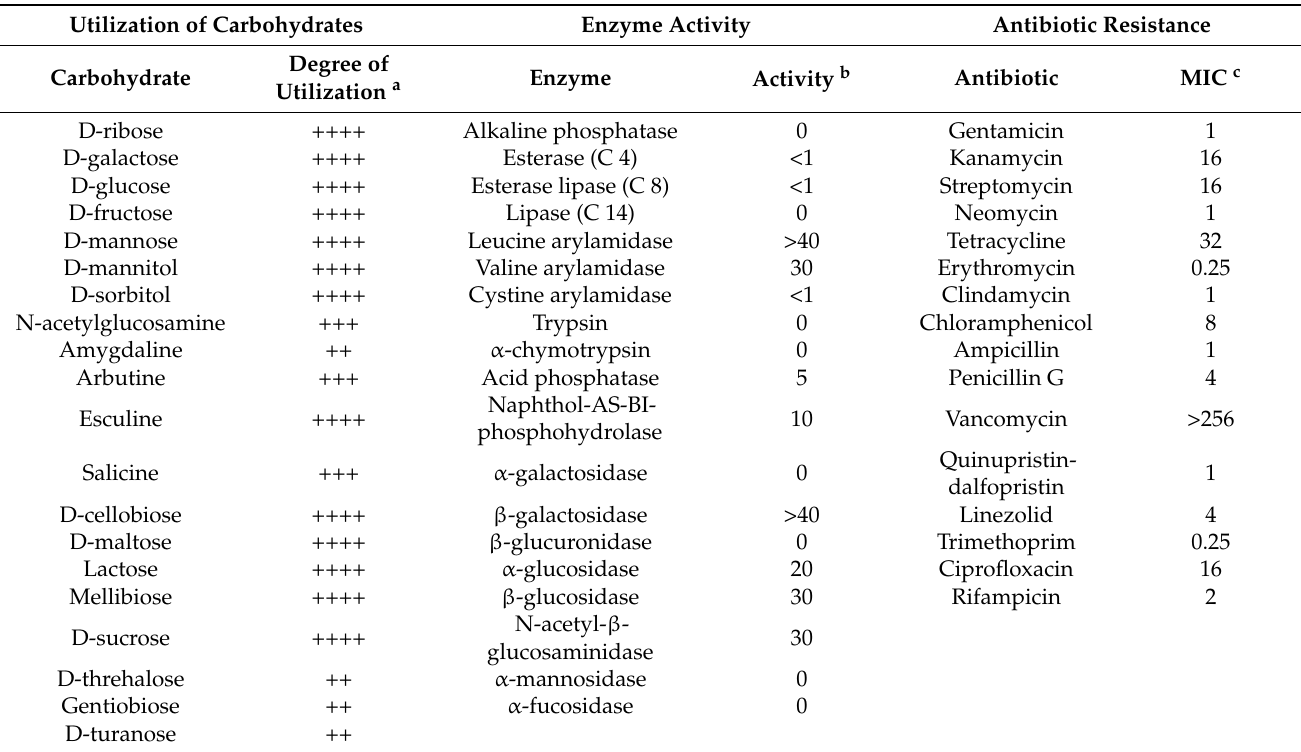
Table 1. Phenotypic characterization of L. plantarum